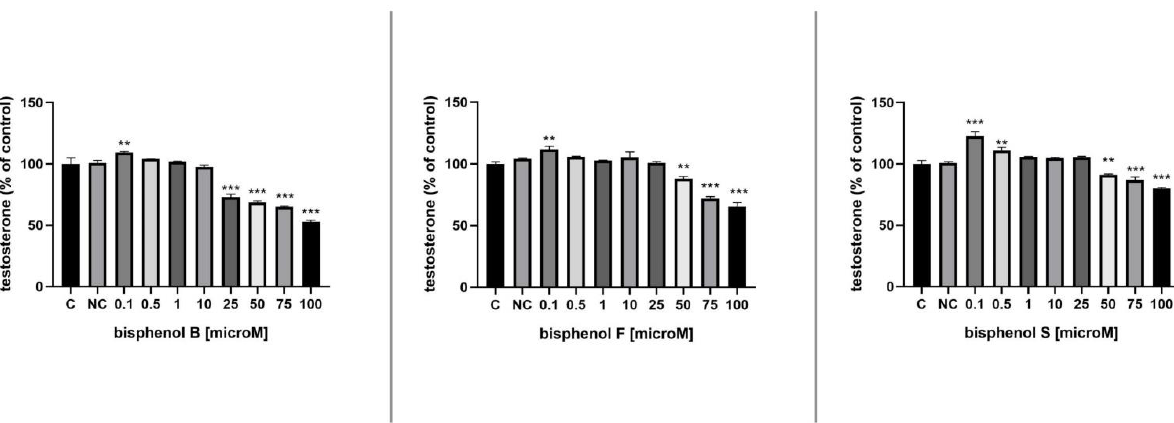
Figure 6. The impact of bisphenol B, F, and S on H295R cells testosterone secretion in vitro. Abbreviations: C—control group, NC—negative control. The mean ( ± SEM) optical density percent of the control (untreated) and treated (bisphenol) groups is represented by each bar. The data were collected from three separate experiments. Between the control and experimental groups, the significance levels were established at *** ( p < 0.001), ** ( p < 0.01).